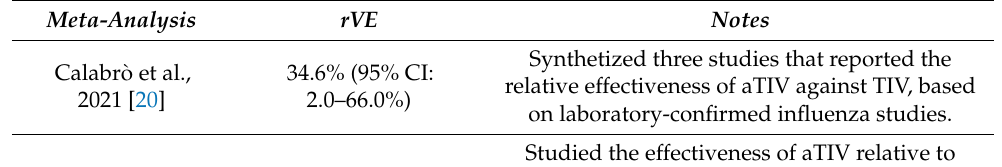
Table 5. aQIV relative vaccine effectiveness (extrapolated from